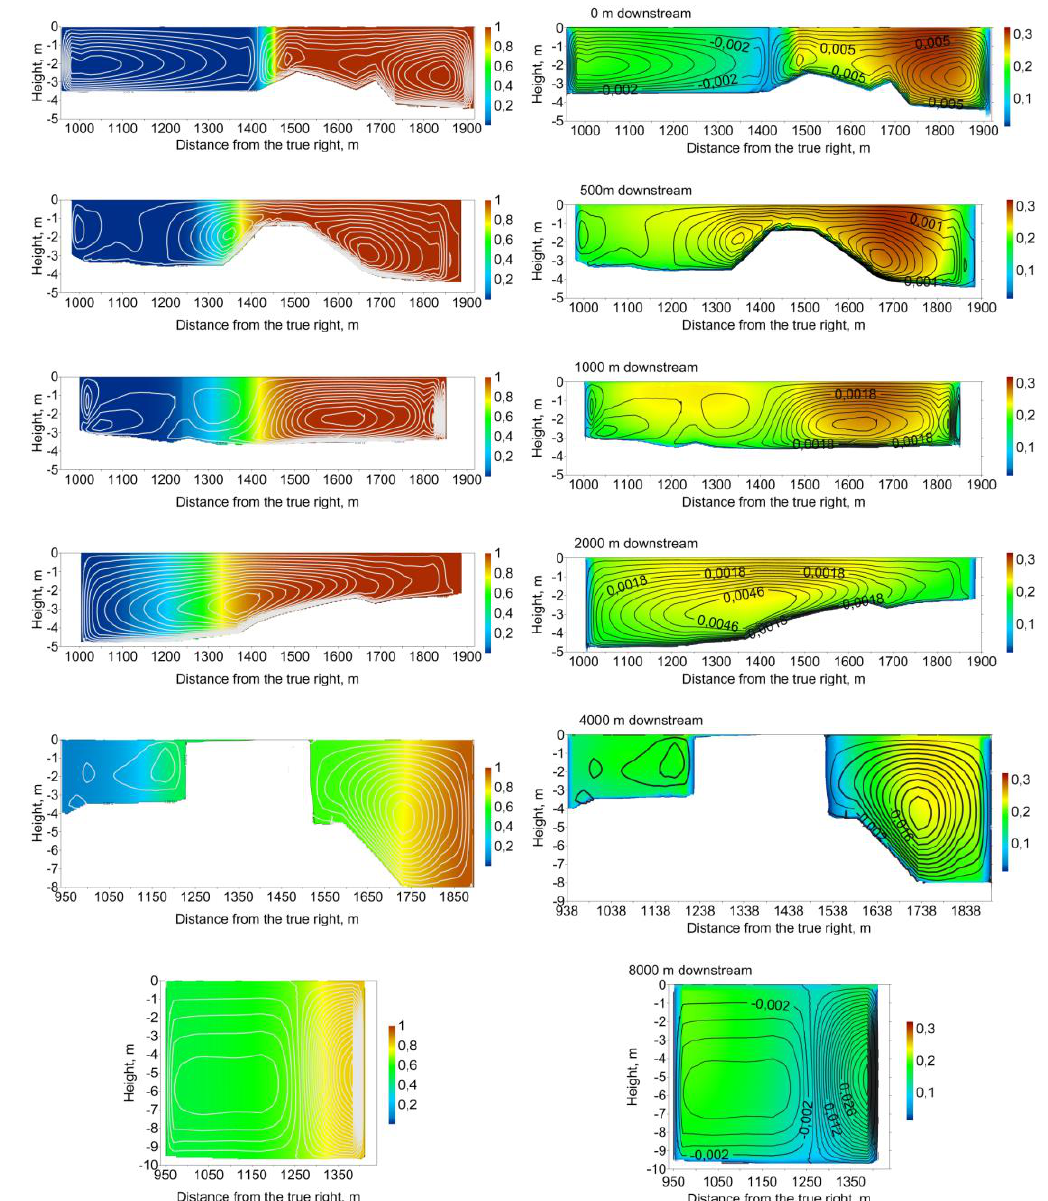
Figure 9. Predictions of concentration ( left ) and primary velocity ( right , m · s − 1 ) with the stream function for Q r = 0.62 and the N simulation geometry. Contours of flux are shown (units of m 2 · s − 1 ) as calculated by the stream function. Plots are viewed looking upstream, such that the Kama is on the left of each plot (i.e., the true right) and the Vishera on the right of each plot (i.e., true left). The contour values are only shown on the primary velocity plots.